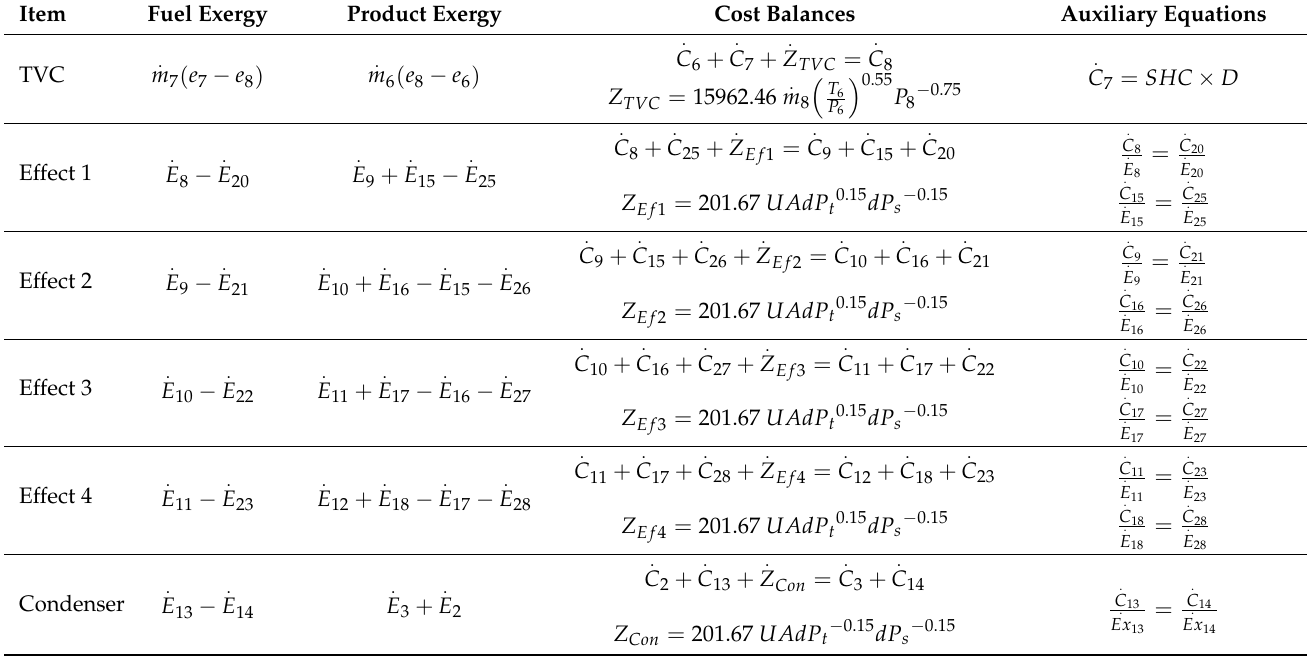
Table 1. Exergy and cost balance equations with corresponding auxiliary equations for the MED-TVC system